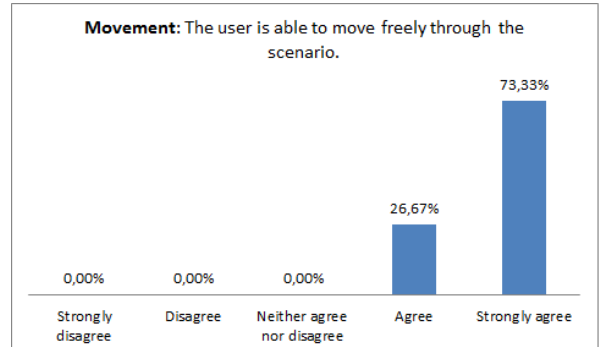
Figure 14: User mobility.